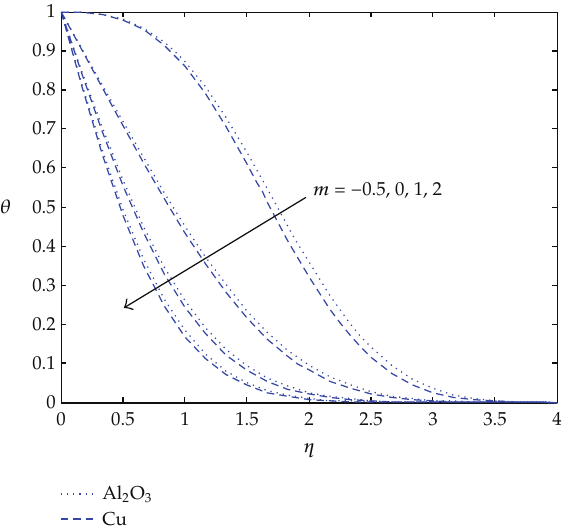
Figure 3: Variation of dimensionless temperature for di ff erent values of parameter m (cid:5) Pr (cid:8) 6 . 2, ψ (cid:8) 0 . 1, p (cid:8) 1, ξ (cid:8) 0 . 1, ∧ (cid:8) 0 . 1 (cid:6)